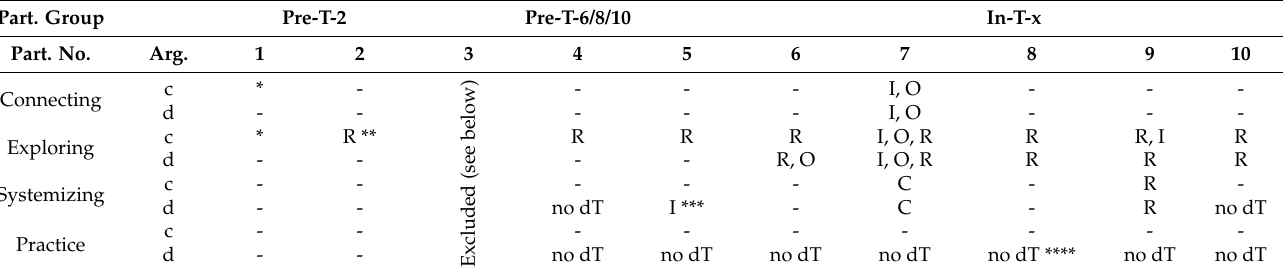
Table 1. Digital technology named for each phase by the